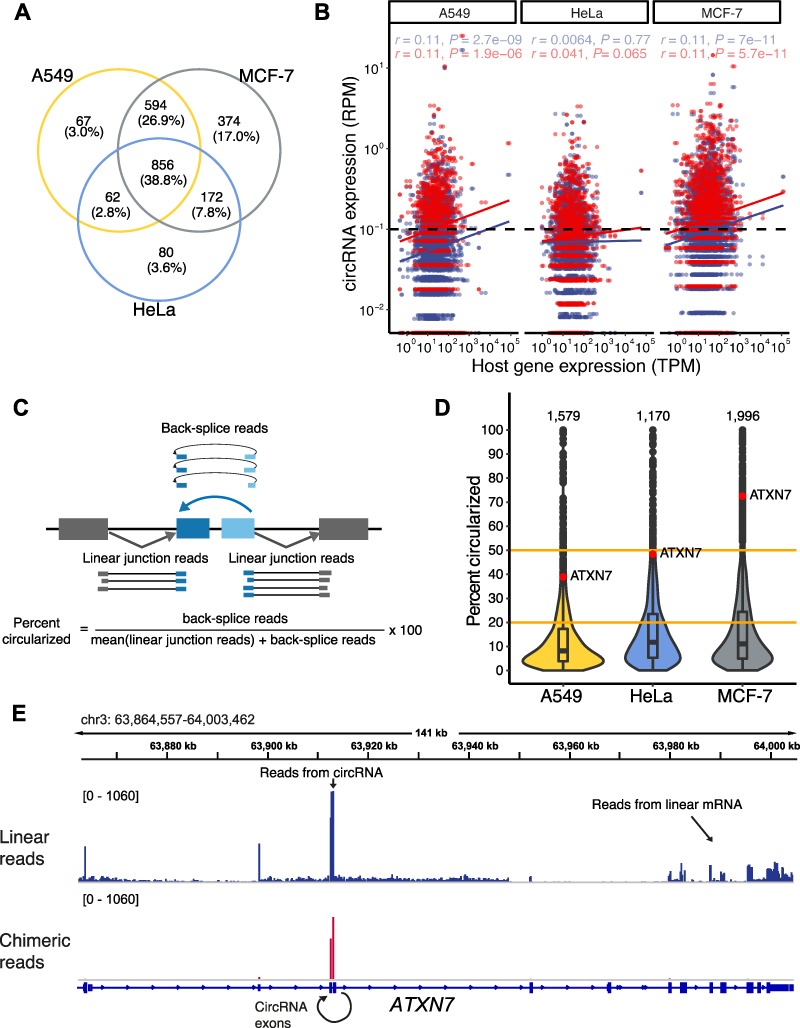
CircRNA profiles in human cancer cells. (A) Comparison of high-confidence circRNAs across A549, HeLa, and MCF-7 (supported by a minimum of 5 back-splice reads in any 2 samples). Most circRNAs are expressed in at least two cell types. A similar partition occurs when a further filter on minimum expression of the host gene is applied (Supplementary Figure S3H). (B) Scatter plot comparing the expression of circRNAs in back-splice RPM to the expression of the host gene in TPM. circRNA expression does not generally reflect the abundance of the host gene. Mean expression across replicates is shown for each cell line under hypoxic (blue) and normoxic (red) conditions. Linear regression lines and Pearson correlation coefficients with associated P-values are reported. (C) Scheme showing how ‘percent circularized’ metric is computed from back-splice reads and reads spanning the corresponding linear splice junctions. (D) In total, 210 circRNAs are more abundant than their linear counterparts, as exemplified by circATXN7 (hsa_circ_0007761; labeled in orange; Huang et al., 2019) in MCF-7 cells. Violin plot shows distribution of ‘percent circularized’ values for circRNAs from the three cell lines (mean per cell line across all replicates and conditions). Orange lines indicate circRNAs with >20% and 50% relative abundance. (E) Genome browser view of ATXN7 gene showing RNA-Seq data from MCF-7 cells under normoxic conditions. Coverage of chimeric alignments (back-splice reads, red, bottom) documents back-splicing of exon 4 to exon 3 to produce circATXN7. The high abundance of circATXN7 is reflected in a peak in the coverage of linearly mapped reads (blue, top) corresponding to internal regions of the circRNA, while the remainder of the linear transcript shows less coverage.